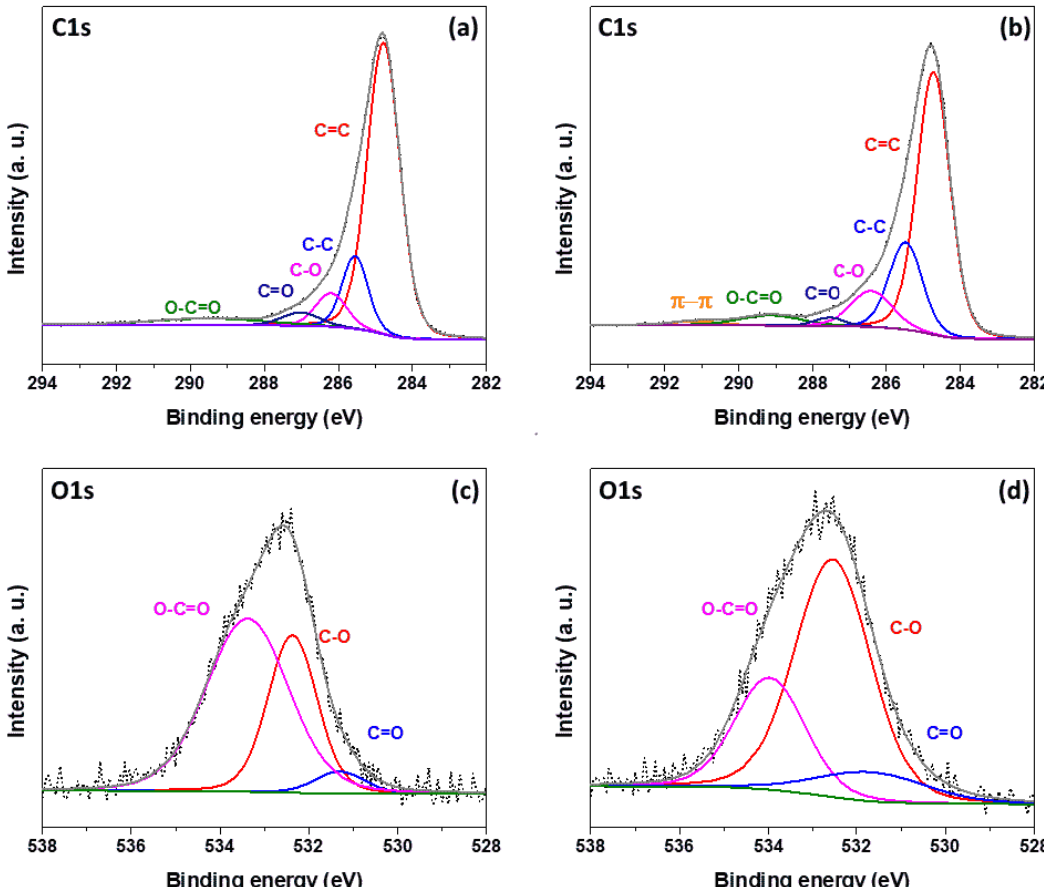
Figure 10. Deconvoluted spectra of graphite felt before ( a , c ) and after ( b , d ) thermal oxidation at 550 °C for 5 h: ( a , b ) C1s spectra, ( c , d ) O1s spectra.